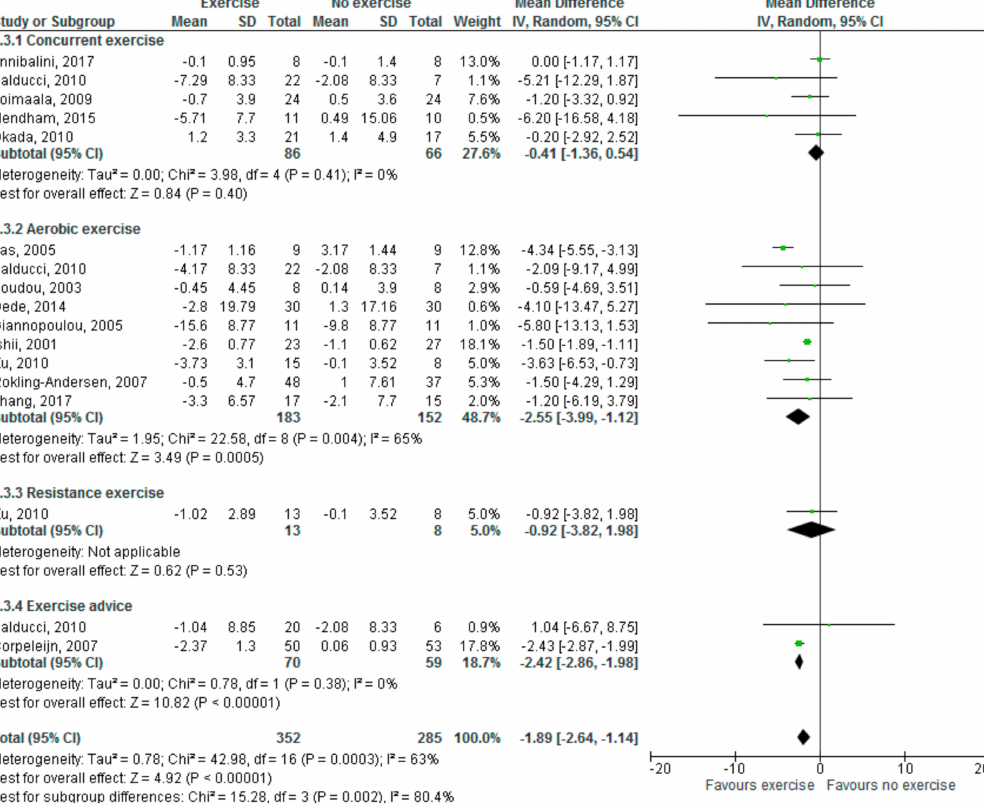
Figure 2. Effects of physical exercise, including different modalities, on leptin levels (ng/mL). Forest plot shows pooled mean differences with 95% confidence intervals (CI) for 17 pooled effect sizes from 14 trials (two separate effect sizes were pooled for different exercise modalities from Ku [51] and three from Balducci [39]). The green colored square represents the point estimate of the effect of the intervention for each trial. The horizontal line joins the upper and lower limits of the 95% CI of the effects. The square area represents the relative weight of the trial in the meta-analysis. The black colored diamond at the bottom represents the pooled mean difference with 95% CI for all study